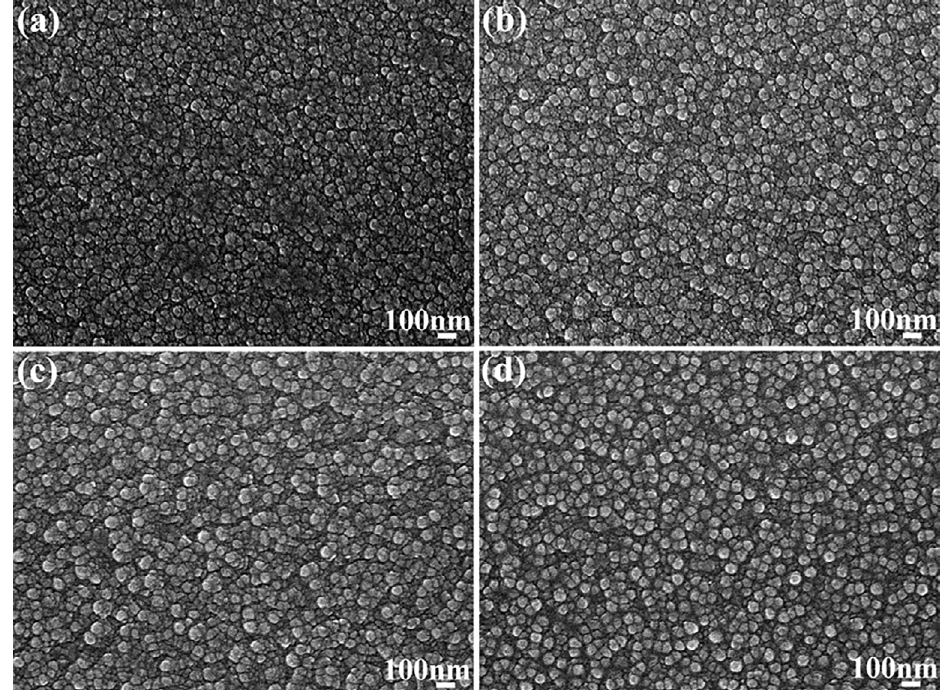
Figure 3. SEM images of the InN samples grown at different sputtering powers: (a) 80W, (b) 90W, (c) 100W and (d) 110